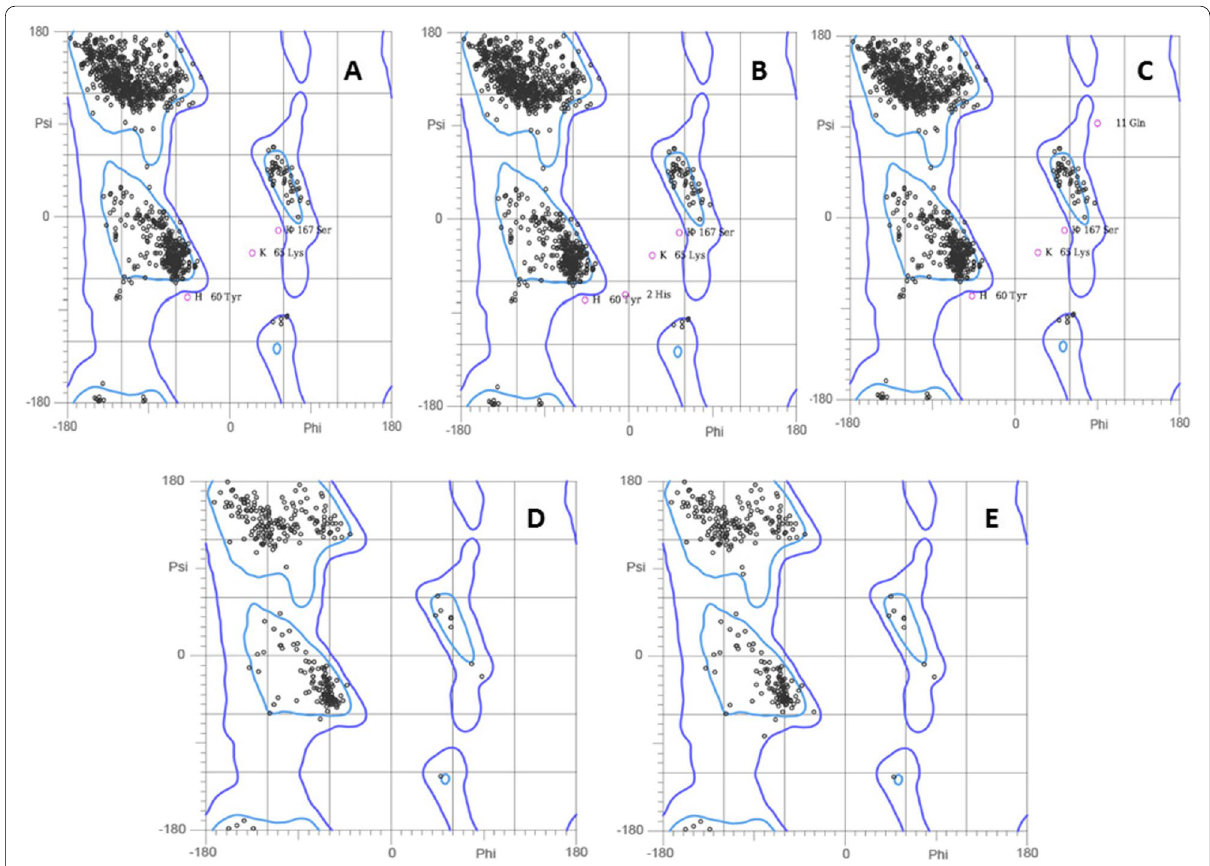
Fig. 5 Ramachandran plots for docked complexes. A 1AQD-GKSFELNQAARAVTQ. B 1AQD-LHRYSYKLAGVNQVD. C 1AQD-RYSYKLAGVNQVDVV. D 1XR9-ITLKLLHRYSYKLAG. E 1XR9-KLVLRAFPNHFRGDS